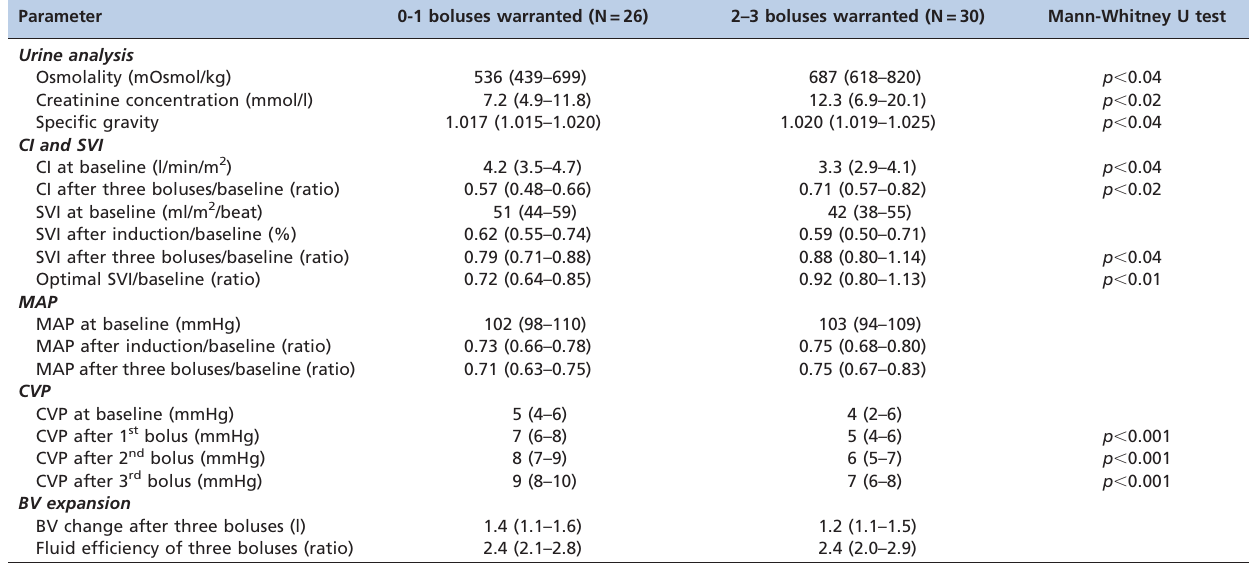
Table 2 - Urine analysis and hemodynamic responses to three boluses of hydroxyethyl starch. Patients who received preloading with Ringer’s lactate are not